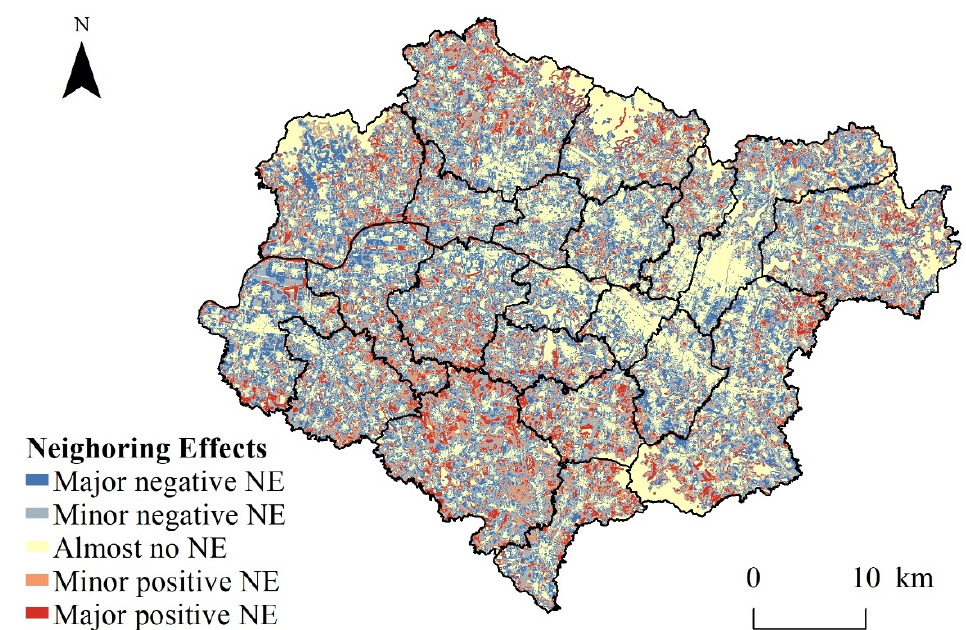
Land 2022 , 11 , x FOR PEER REVIEW Figure 4. Neighboring effects by patches in Xintai City. Figure 4. Neighboring effects by patches in Xintai City.